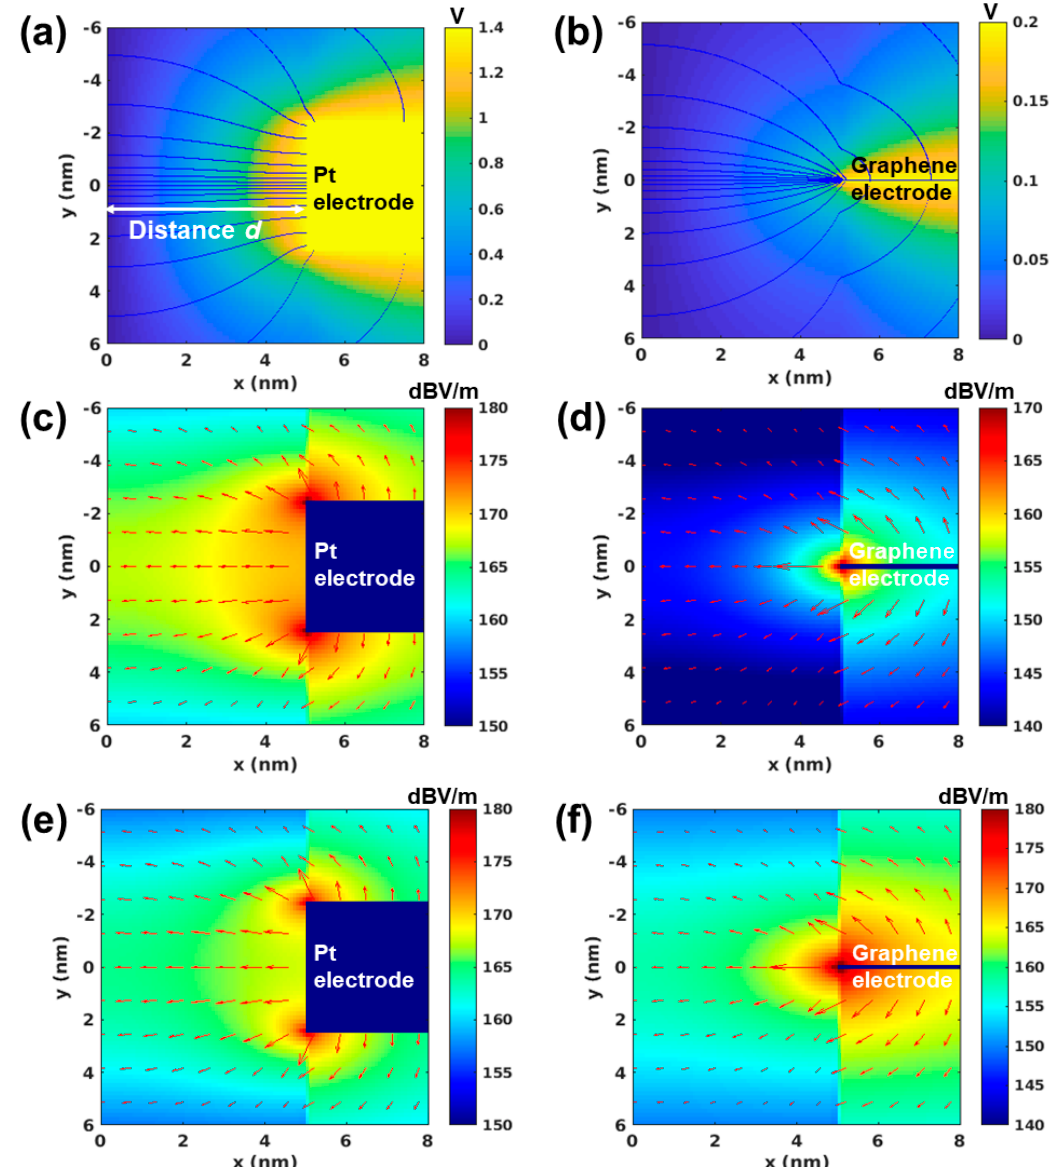
Figure 3. A comparison of the electric potential for ( a ) Pt and ( b ) graphene electrodes, and the electric field for ( c ) Pt and ( d ) graphene electrodes. Similarly to the experimental characterization settings, 1.4V of electric potential is applied to the Pt electrode and 0.2V to the graphene electrode while the TiN electrode is grounded; ( e , f ) The electric field strength comparison under equal potential conditions (1V) for graphene and Pt-based VRRAMs. The TiN electrode is placed at the plane of x = 0 (nm) and plane electrodes are sandwiched between the SiO 2 dielectric layers. The figures ( a ) and ( b ) show the electric potentials with the electric flux lines overlaid. In ( c – f ), the strength of the electric field is denoted by the colormap in the unit of (dBV / m). The red arrows also represent the electric field distribution including the direction of the